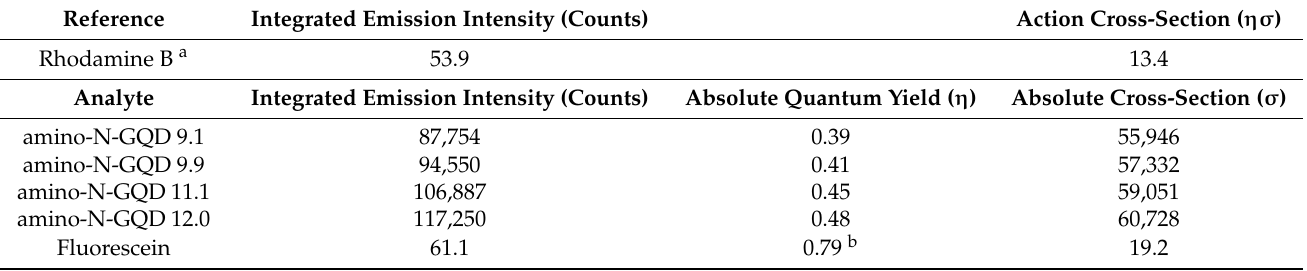
Table 1. TPE cross-section of materials at an excitation wavelength of 960 nm. Delivered dose: